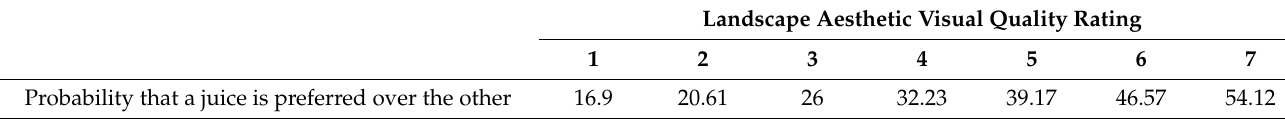
Table 5. Estimation of the probability that a juice was preferred (according to the overall liking score) over the other in the same pair as the landscape individual preferences score varies (probability expressed in percentage values).